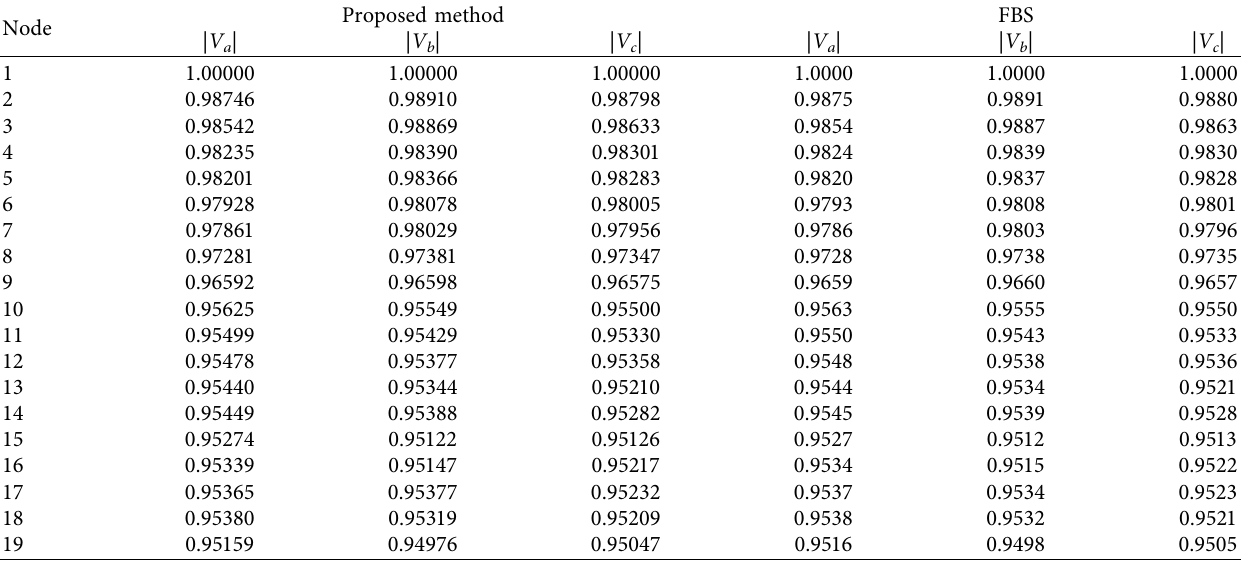
Table 10: Voltage profile of 19-bus